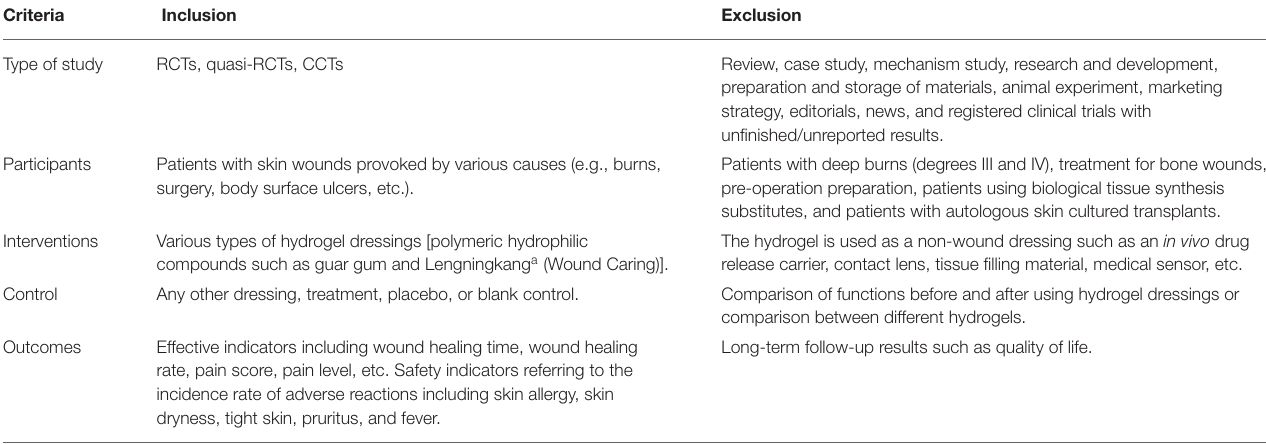
TABLE 1 | Inclusion and exclusion criteria. Criteria